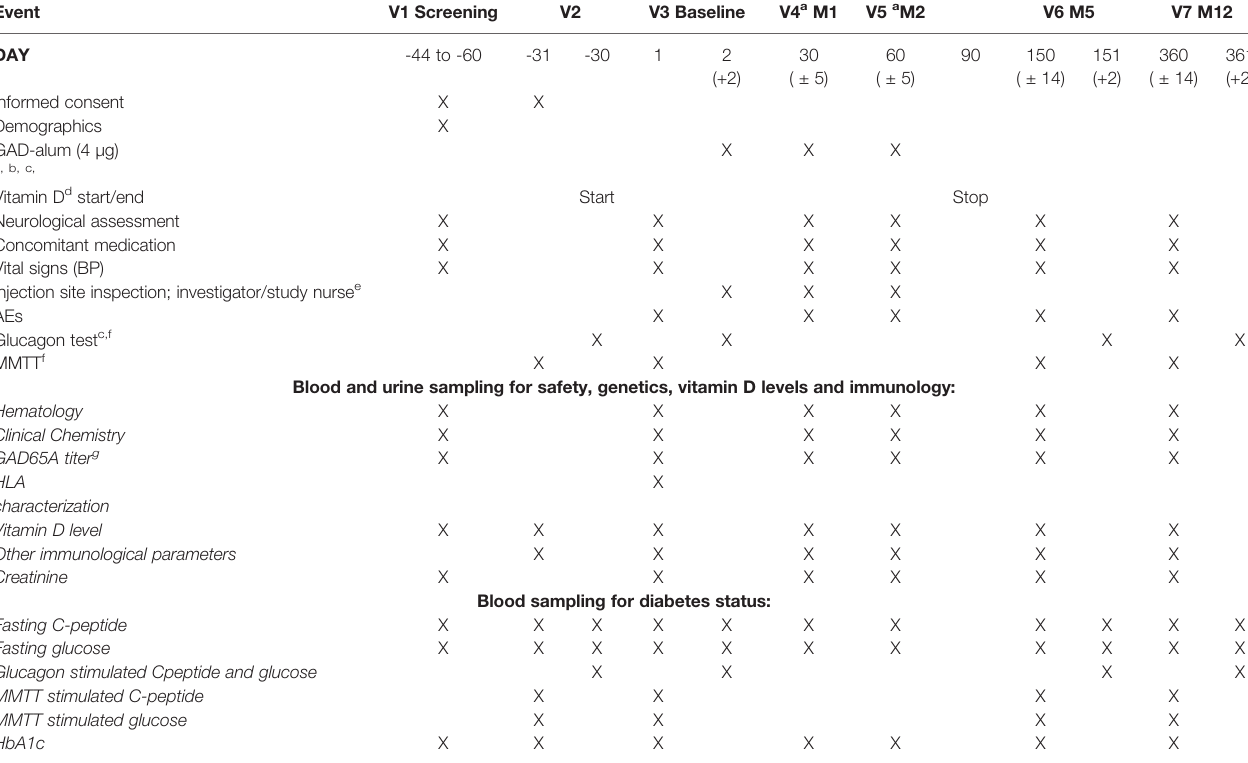
Table 2 : V, visit; M, month; GAD, Glutamic Acid Decarboxylase; BP, Blood Pressure; AEs, Adverse Events; MMTT, Mixed Meal Tolerance Test; GAD65A, Glutamic Acid Decarboxylase Antibodies; HLA, Human Leukocyte Antigen; HbA1c, Hemoglobin A1c]. a Studydrugadministration:Forvisit4and5thevisitdatemustbesetinaccordancewithvisit3and4,respectively,sothatthe fi rst,secondandthirddoseswillbe30daysapart(±5days). b The GAD-alum injection directly into the inguinal lymph node is to be done by an appropriately quali fi ed radiologist at the X-ray department at the study site by help of ultrasound technique. c On day two at visit 2, the glucagon test needs to be done before the injection of GAD-alum. d SupplementationwithvitaminDstartsatday-30,aftertheglucagontesthasbeenperformed,ifthevitaminDserumlevelsarebelow100nmol/L(40ng/ml)atscreening.Ifthepatienthas vitamin D serum levels above 100 nmol/L (40 ng/ml) at screening, no Vitamin D supplementation will be given for that patient. e The investigator/study nurse will inspect the injection site before and after the injection is given and record any injection site reactions in the Case Report Form (CRF). f The MMTT and the Glucagon test must be carried out on separate days, as each test must be performed in the fasting state. g Antibodies against IA-2 (islet cell antigen 2), ZnT8 (Zink transporter 8) and insulin will be measured at Baseline and at Visit 7.